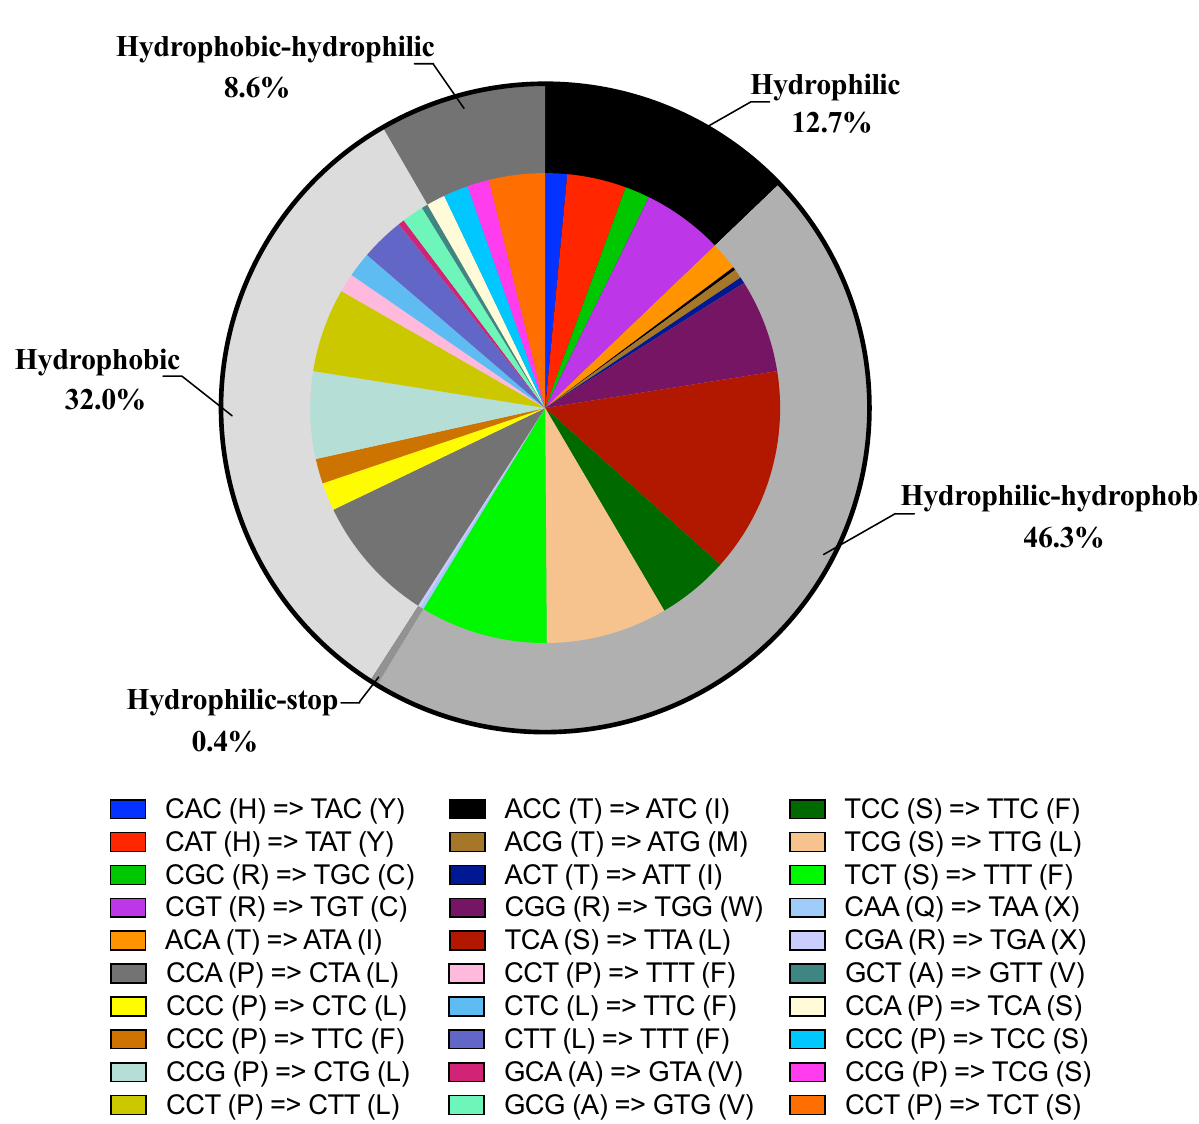
Figure 5. Depth and coverage of the assembled mitogenome using sequencing long-reads. The abscissa shows the genomic positions, and the ordinate shows the depth of mapped raw reads.